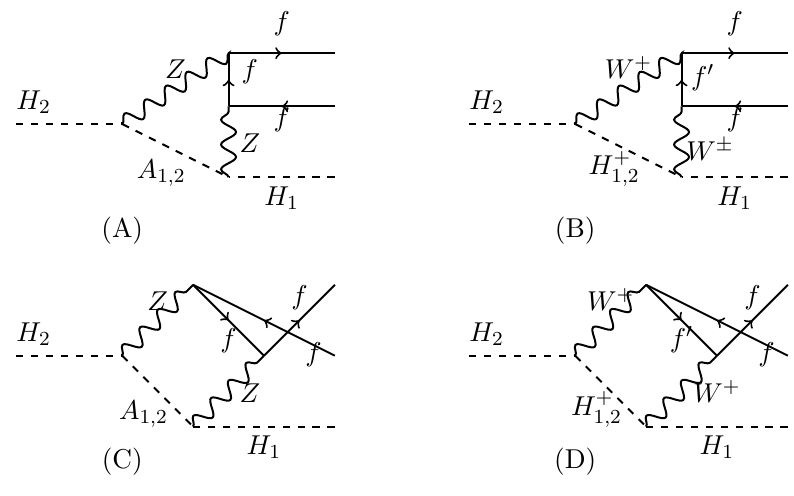
Figure 5 . Box diagrams contributing to H 2 ! H 1 f (cid:22) f